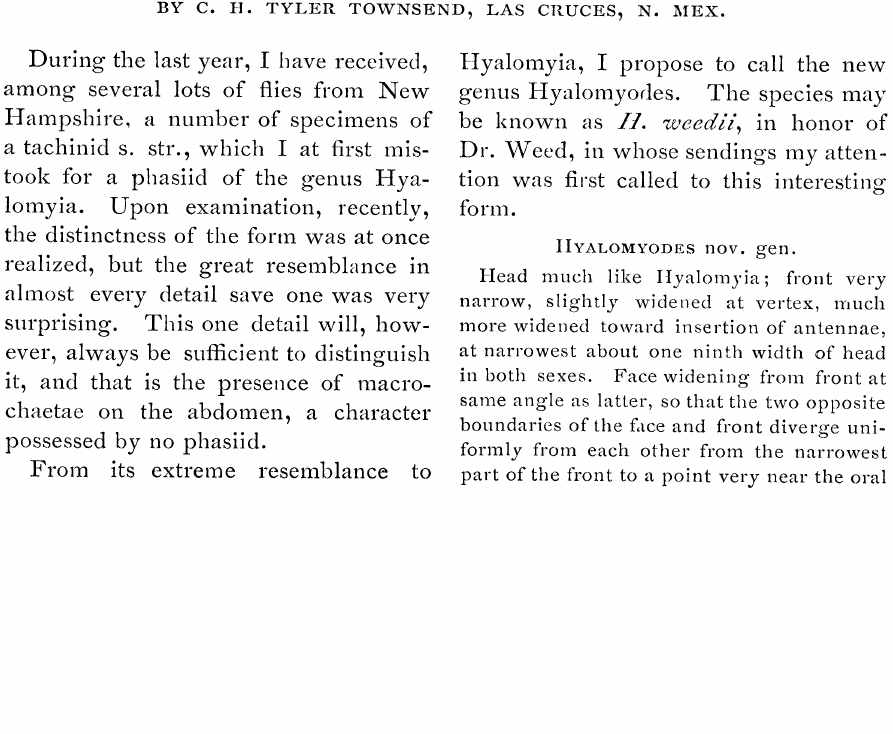
PLATE 12. Fig. I.--Liobunum viltalum. Female. Nat- ural size. 2.--Parts of same. Magnified. 2a.--Body. 2b.--Eye eminence. Side view. 2c.--Eye eminence. Front view. 2d.--Palpus. Side view. 2e.---Claw ofpalpus. Side view. PLATE I3. Fig. I.--Liobunum ventricosum (Wood), male. Natural size. 2.Parts of same. Magnified. 2a.--Body. 2b.Eye eminence. Side view. 2c.Eye eminence. Front view. 2d.--Palpus. Side view. 2e.Claw ofpalpus. Side view. 2fMaxillary lobe of second pair of legs,